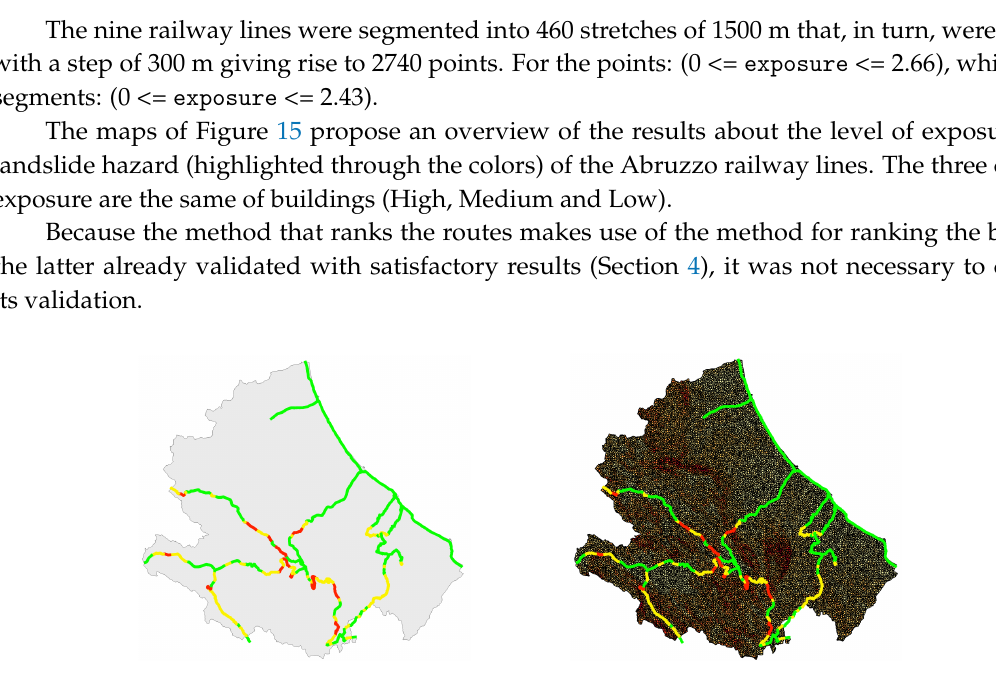
Figure 15. Two different views of the level of exposure of the railway lines of Abruzzo.